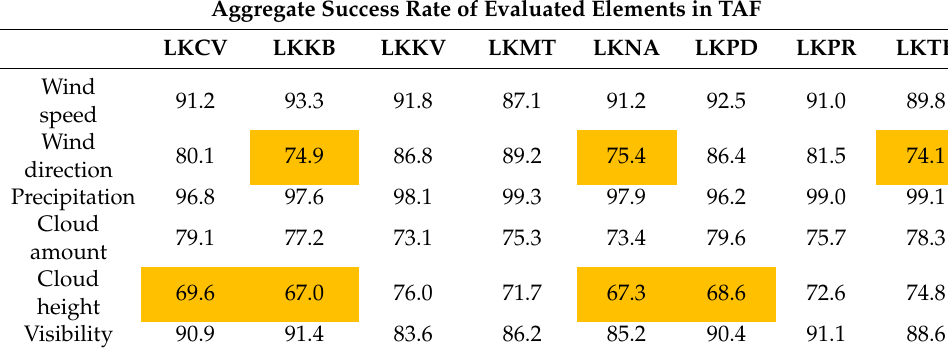
Table 10. Success rate of evaluated elements in TAFs per